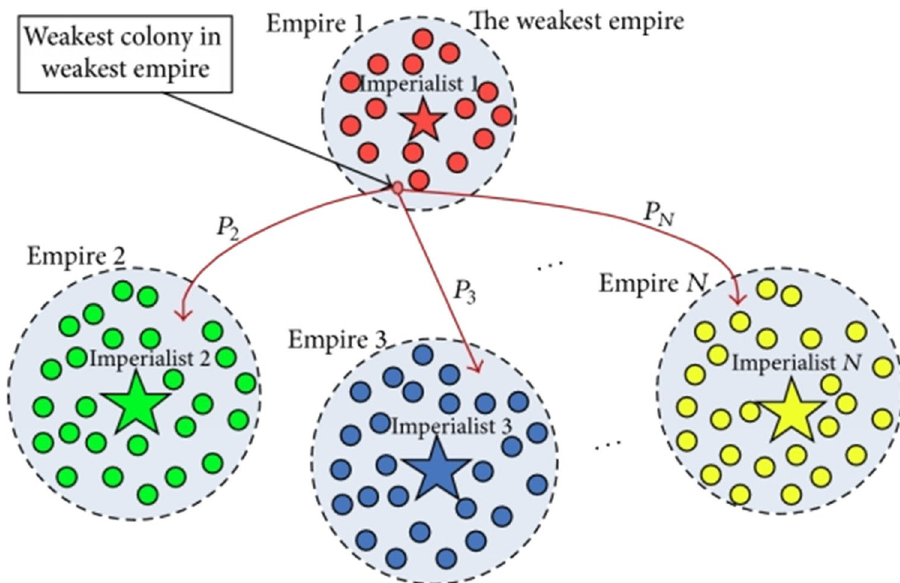
Fig. 7 Imperialistic competition (Khalili et al. 2016